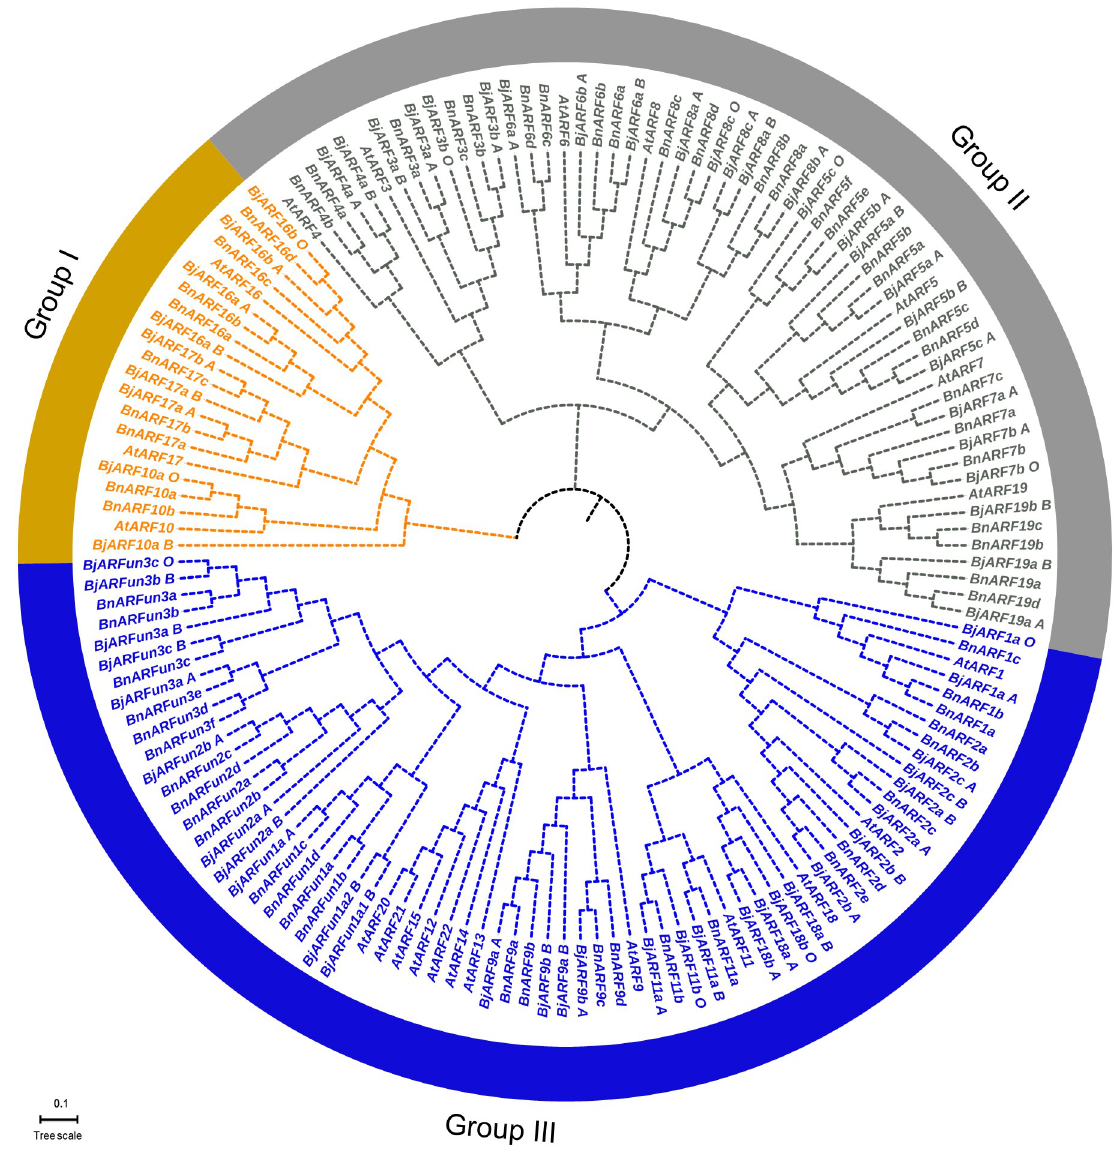
Fig 2. Phylogenetic relationships of ARF genes from three different species ( B . juncea , Arabidopsis thaliana , and Brassica napa ). The phylogenetic tree was constructed using MEGA 7.0 via the Neighbor-Joining method with 1,000 bootstraps. Different groups of the ARF family are represented in different